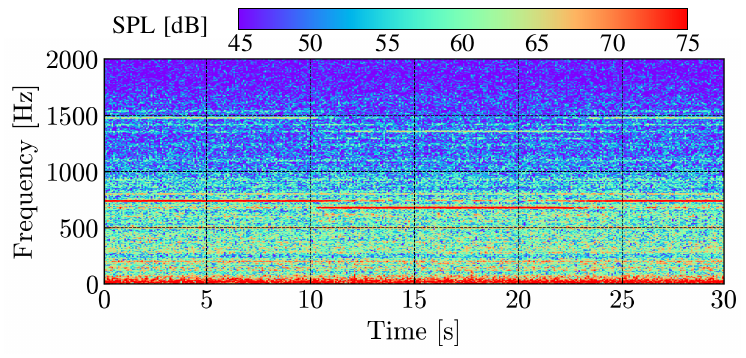
Figure 5. Spectrogram of pressure fluctuation p (cid:48) proved by the microphone at ( r , θ ) = ( 750 mm, π /2 )